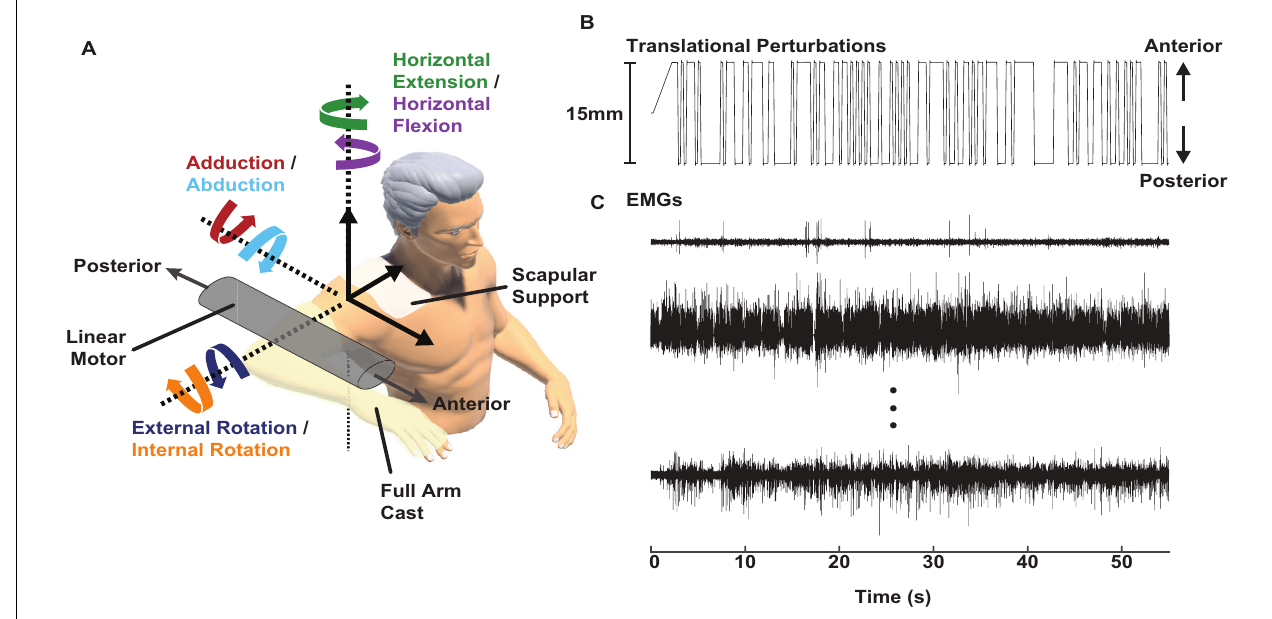
FIGURE 1 | Experimental setup. (A) A linear motor applied anterior-posterior perturbations to the glenohumeral joint while participants produced multiple levels of submaximal isometric torque in six directions. (B) Perturbations with a pseudorandom binary sequence and 15 mm peak-to-peak amplitude were applied to the glenohumeral joint. (C) Electromyograms (EMGs) were recorded in nine shoulder muscles while the participants held isometric torque and the linear motor applied perturbations. Representative samples are shown from the supraspinatus, infraspinatus , and pectoralis major (top to bottom).